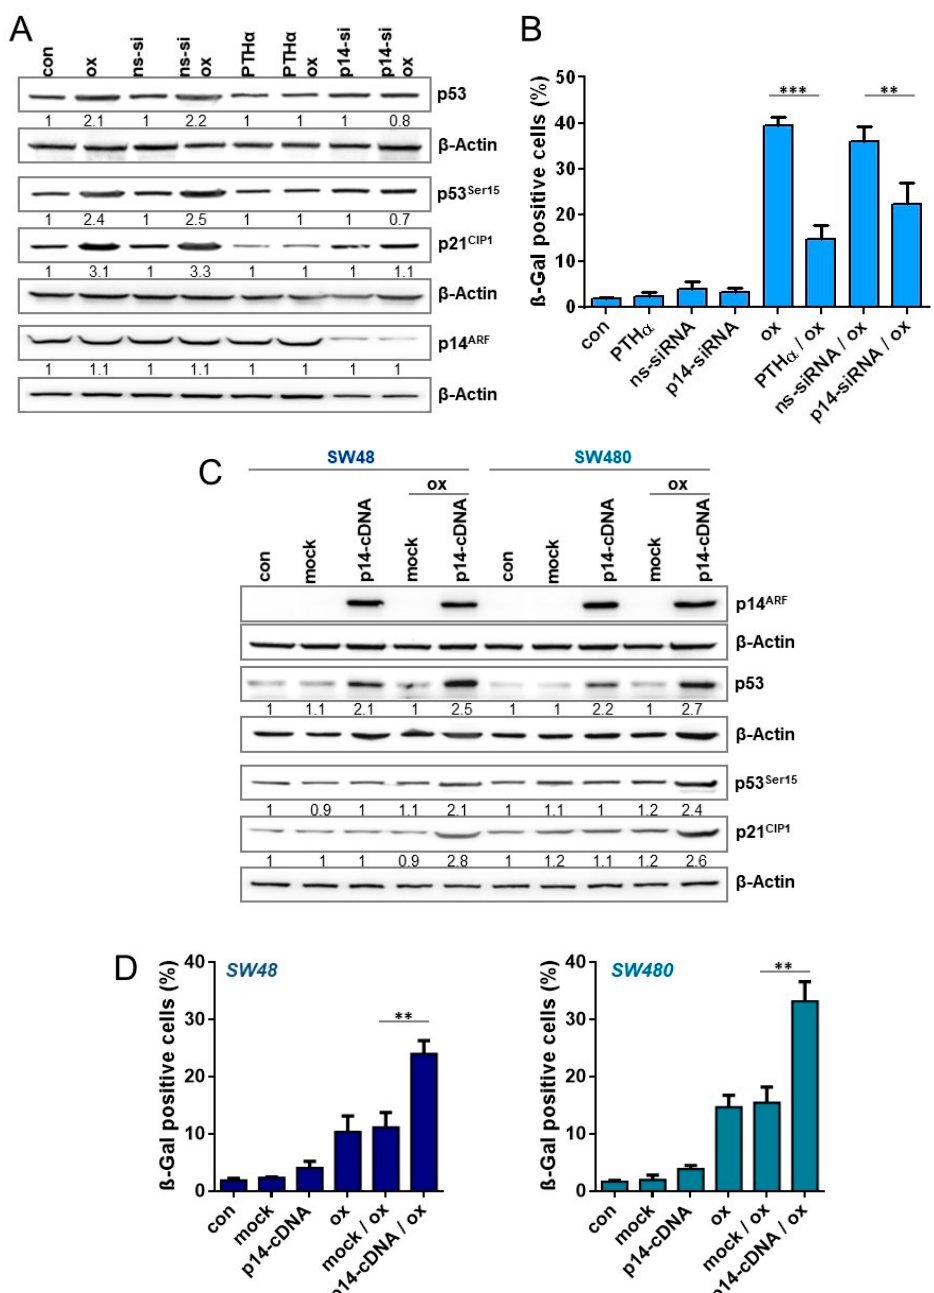
12 of 23 Figure 6. ( A ) CRC cells were treated with 2.5 µM oxaliplatin; 120 h later, the expression of p14 ARF and p16 INK4a mRNA was measured by qPCR. Cq values of the 120 h-control are provided for all cell lines. ( B ) Genomic DNA obtained from CRC cells was modified by bisulfite conversion and the 5meC methylation of p14 ARF and p16 INK4a was measured by methylation-specific PCR (MSP). U=un- methylated, M = methylated, A = ACTB (positive control). ( C ) CRC cells were treated with 2.5 µM oxaliplatin. 120 h later, the expression of p14 ARF was determined by western-blot analysis. β -Actin was used as internal loading control. 3.7. Impact of p53 and p14 ARF on Oxaliplatin-Induced Cellular Senescence To analyze whether the expression of p14 ARF is associated with sustained activation of the p53/p21 CIP1 response in LoVo cells, p14 ARF was downregulated via siRNA. Further- more, to verify that oxaliplatin-induced senescence requires p53, p53 was inhibited using 30 µM pifithrin α (PTH α ). Under these conditions, inhibition of p53 completely blocked the oxaliplatin-induced increase in p21 expression, and knockdown of p14 ARF was accom- panied by an abrogated oxaliplatin-induced stabilization and phosphorylation of p53 as well as by abrogated p21 CIP1 induction (Figure 7A), indicating that p14 ARF is involved in stabilization and phosphorylation of p53 and, thereby, in the sustained upregulation of p21 CIP1 . Next, we measured the oxaliplatin-triggered induction of senescence upon inhibi- tion of p53 and knockdown of p14 ARF (Figure 7B). As expected, inhibition of p53 nearly completely abolished senescence induction. Most importantly, also knockdown of p14 ARF significantly reduced onset of senescence to a level observed in SW48 and SW480 cells. To analyze whether expression of p14 ARF could enhance senescence frequency in SW48 and SW480 cells, the cells were transiently transfected with a p14 ARF expression plas- mid [14] (Figure 7C). Under these conditions, p14 ARF was detectable in SW48 and SW480 cells 120 h after transfection. The expression of p14 ARF was accompanied by an increased stabilization of p53 independent of oxaliplatin treatment. Opposite, enhanced phosphor- ylation of p53 as well as enhanced p21 induction was only observed in p14 ARF